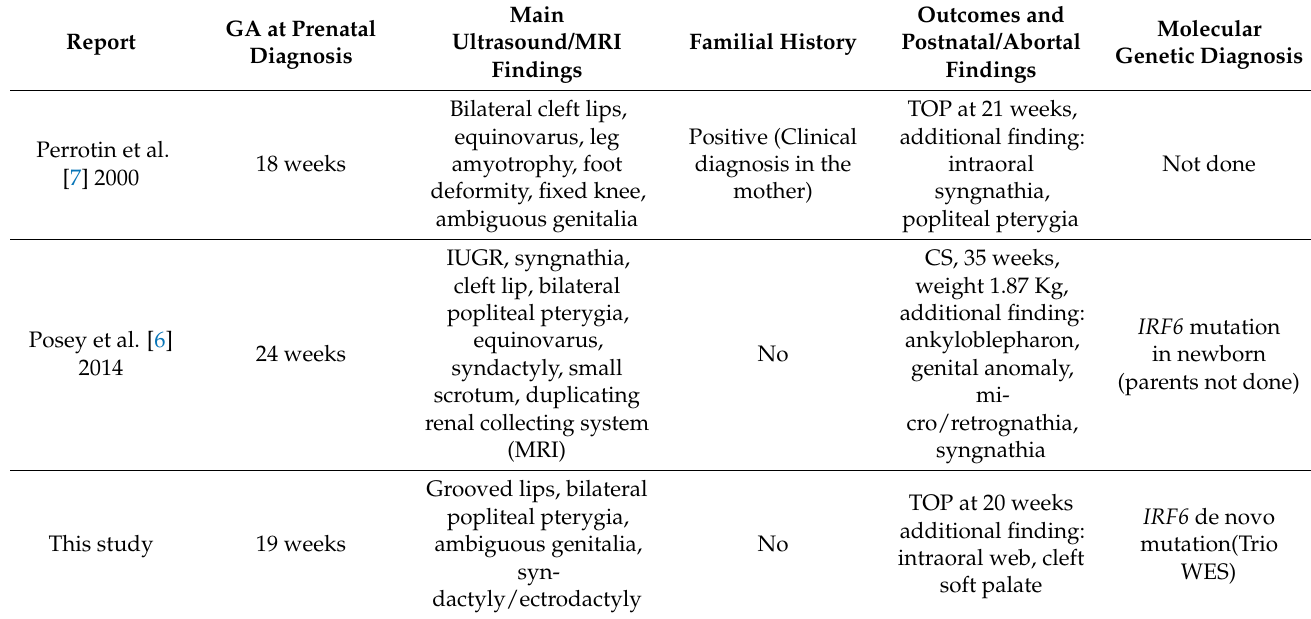
Table 1. Summary of prenatal diagnosis of popliteal pterygium syndrome (PPS) with postnatal/abortal associations. Main GA at Prenatal Ultrasound/MRI Familial History Report Diagnosis Findings